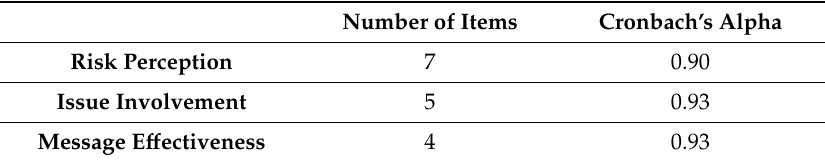
Table 4. Assessment of internal